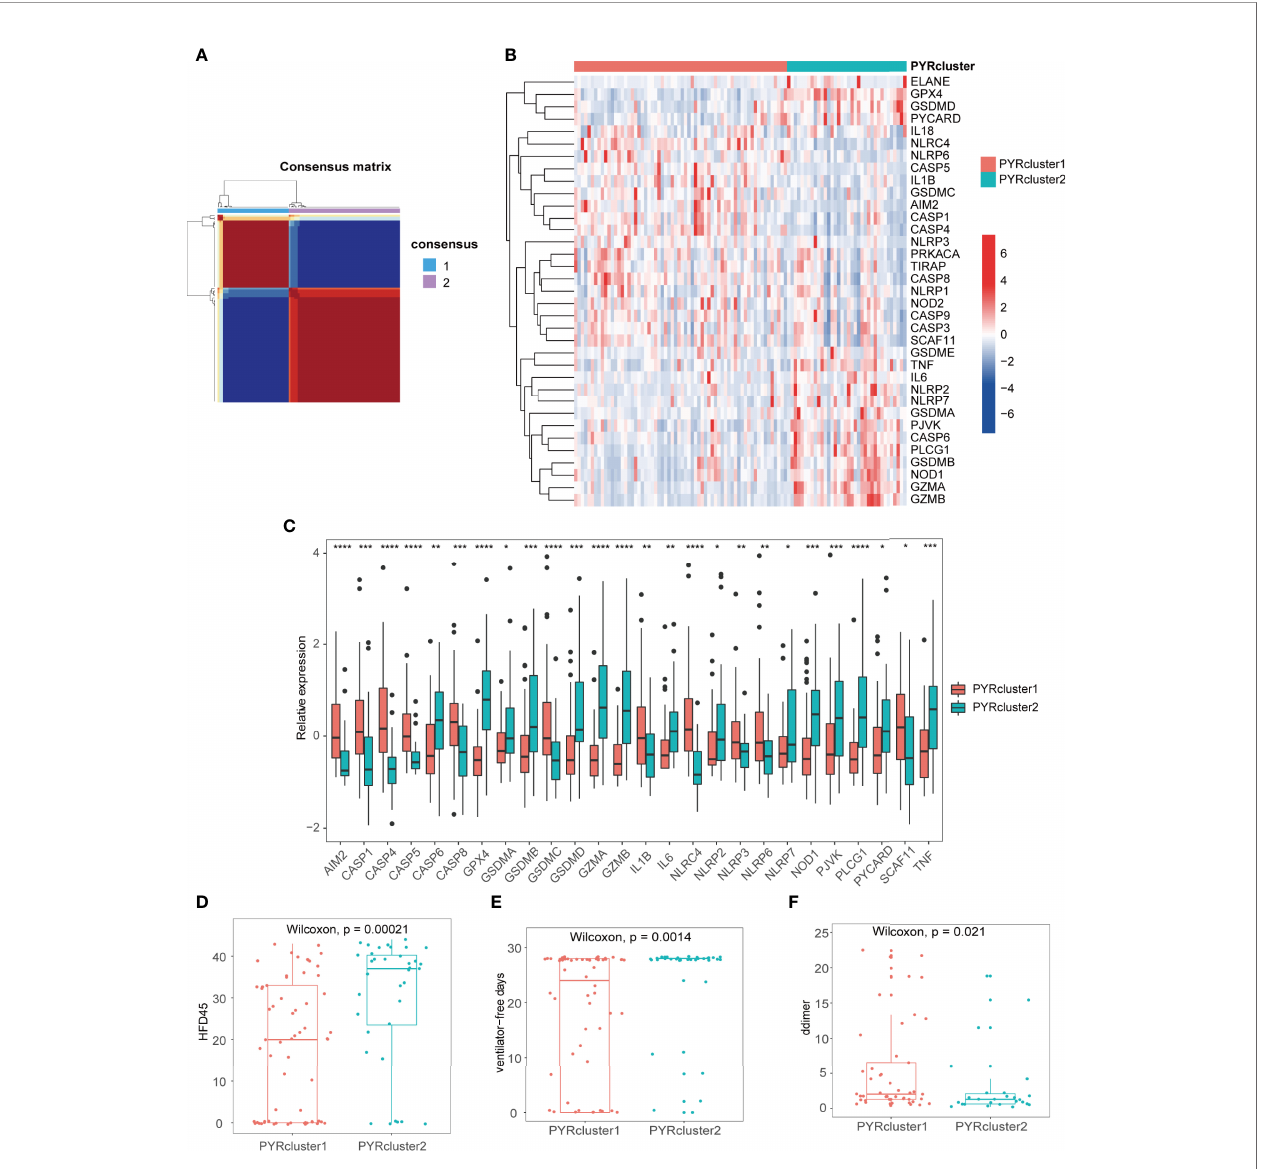
FIGURE 3 | (A) Consensus clustering matrix for k = 2. (B) The heatmap of 35 pyroptosis-related genes between the two PYRclusters. Red represents high expression; blue represents low expression. (C) Boxplot of signi fi cant pyroptosis-related genes ’ relative expression between two PYRclusters. (D – F) The HFD45, ventilator-free days, D-dimer levels between the two PYRclusters. *p < 0.05, **p < 0.01, ***p < 0.001, ****p < 0.0001, ns, no signi fi